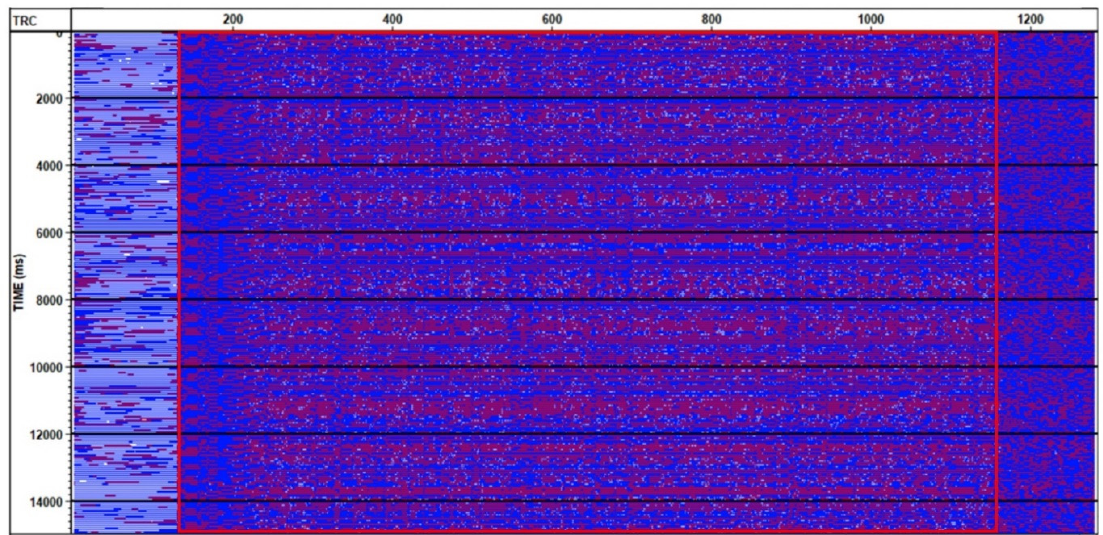
Figure 1. A fragment of the DAS record before processing. The area of interest highlighted in red is due to the technical peculiarities of the data collection.